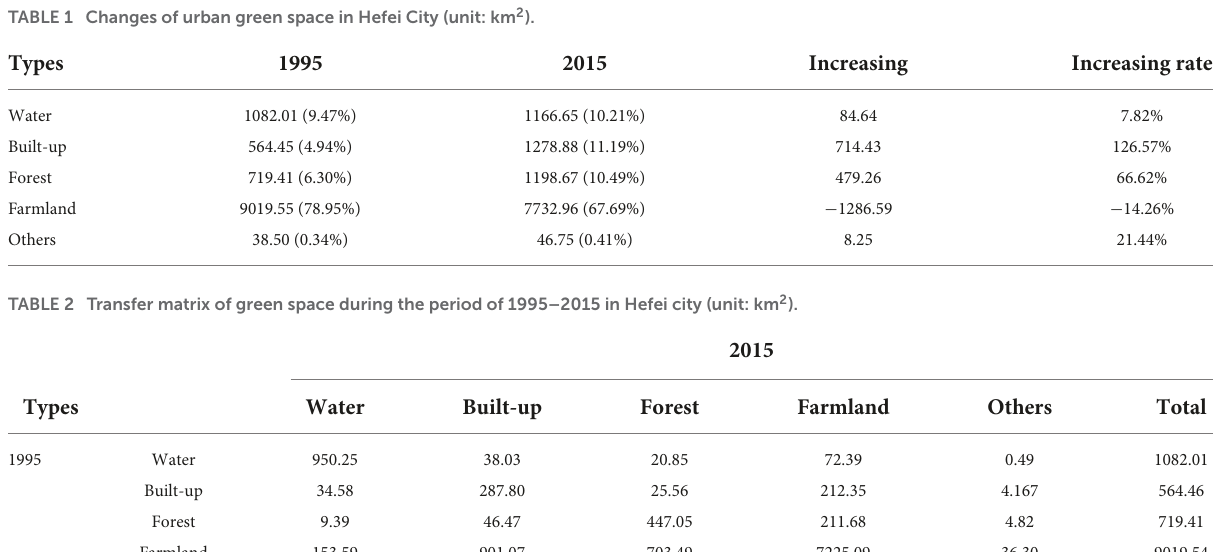
TABLE 1 Changes of urban green space in Hefei City (unit: km 2 ).